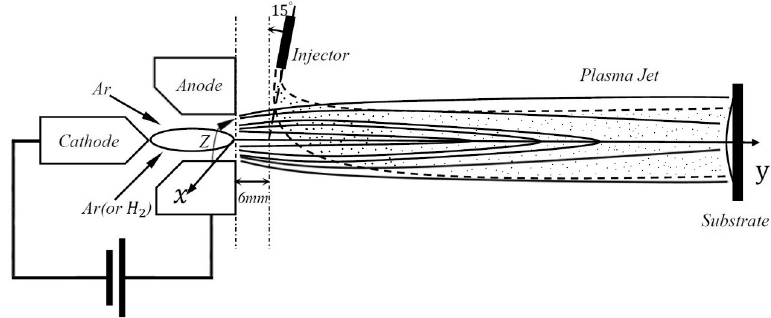
Figure 1. Schematic of solution precursor plasma spraying with radially ‐ injected droplets.